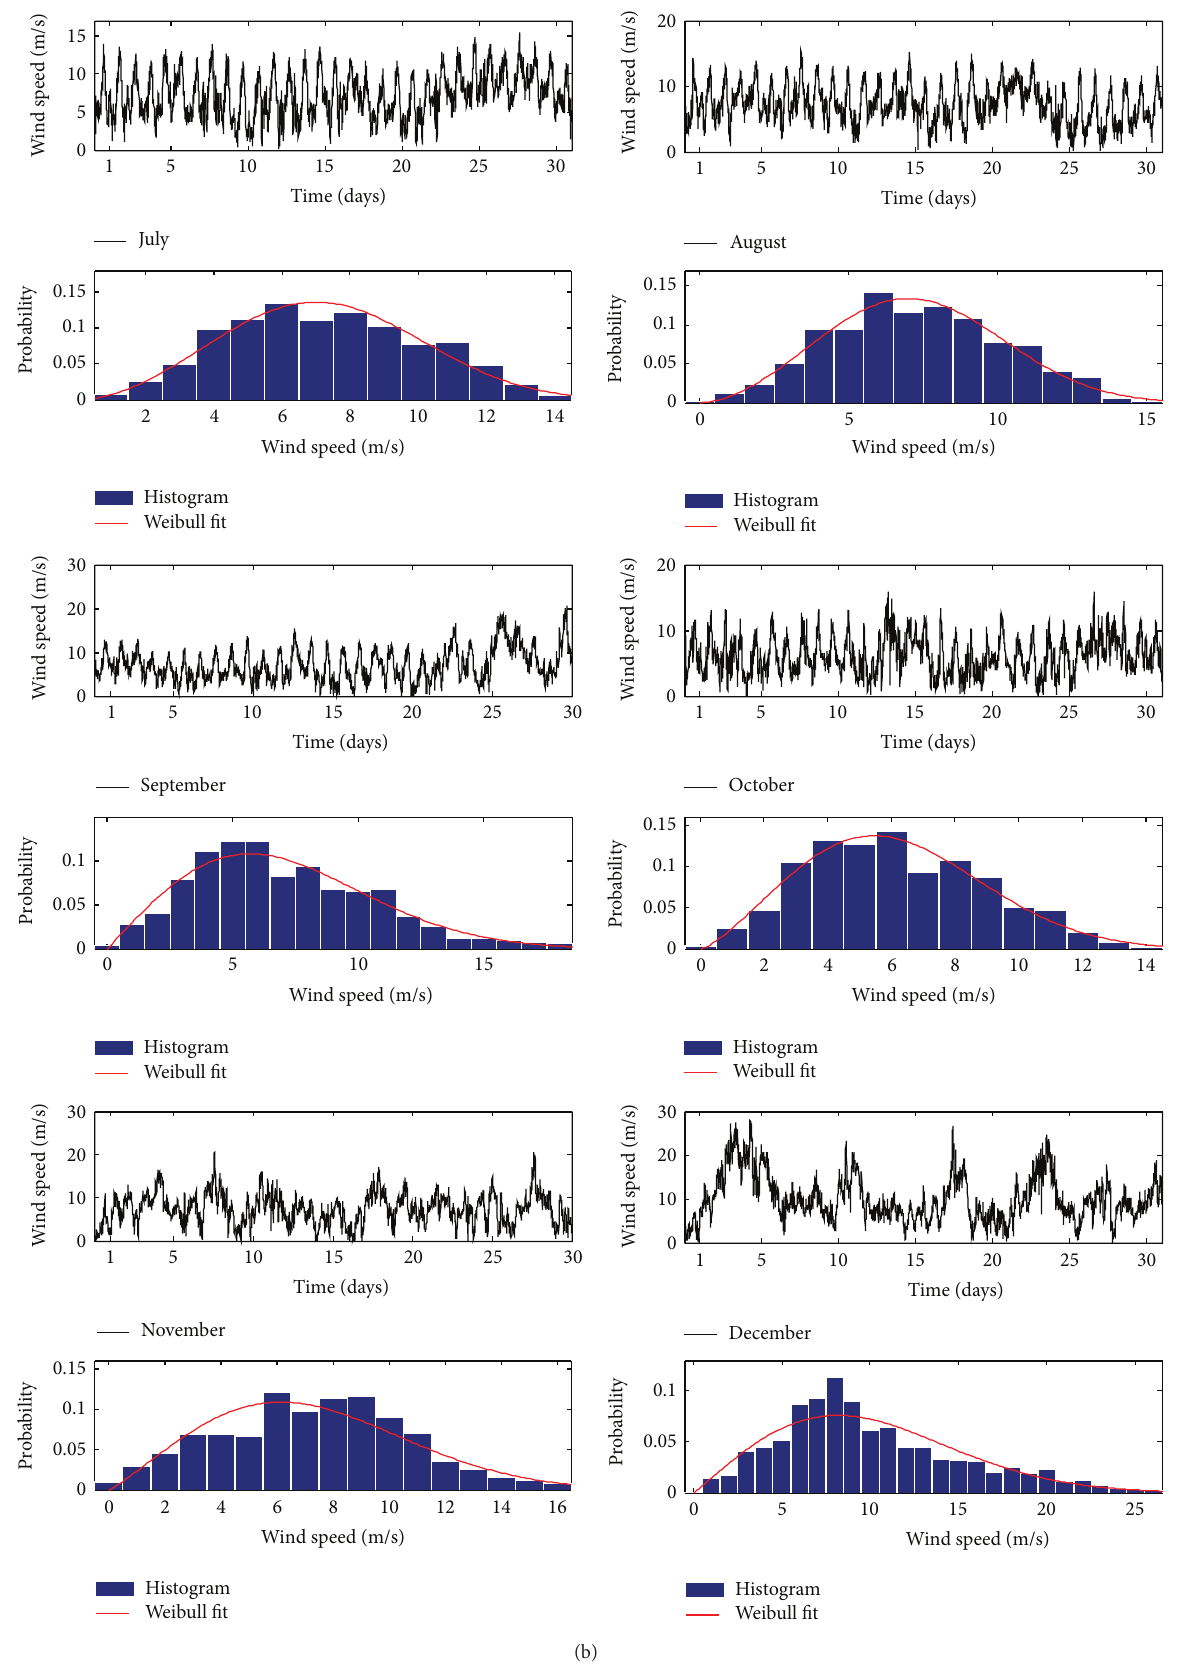
Figure 4: Monthly 2008 wind raw data in Ariel and appropriate